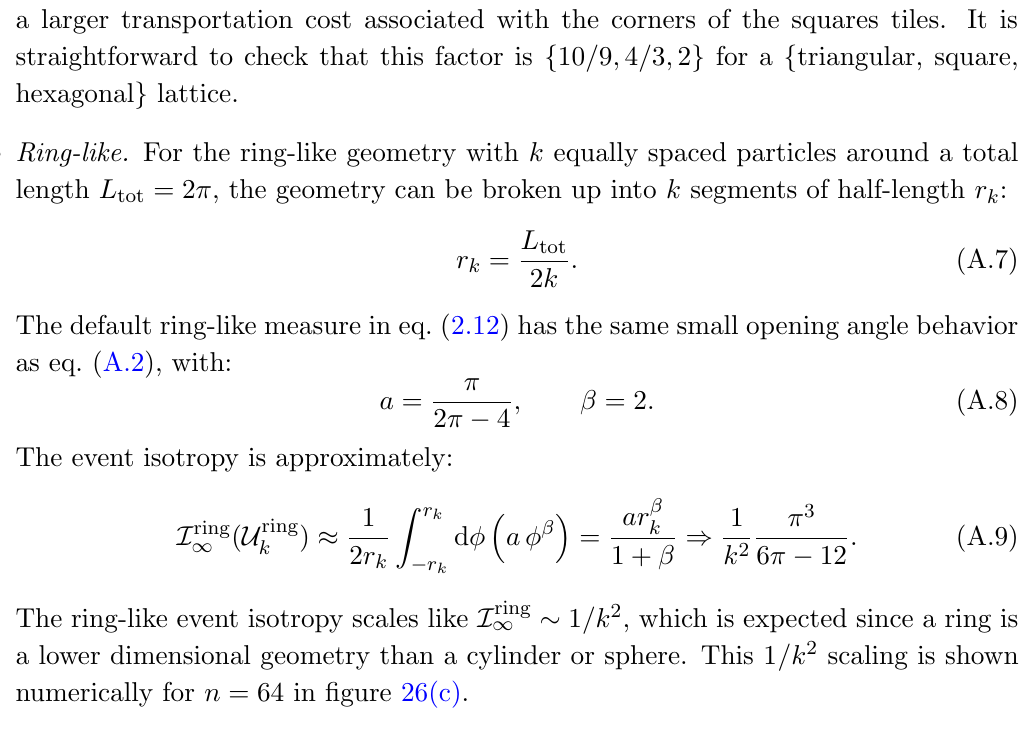
Figure 27 . Two back-to-back particles E sph total momentum of the two particles is 20% of the total event momentum ( x = 0 :